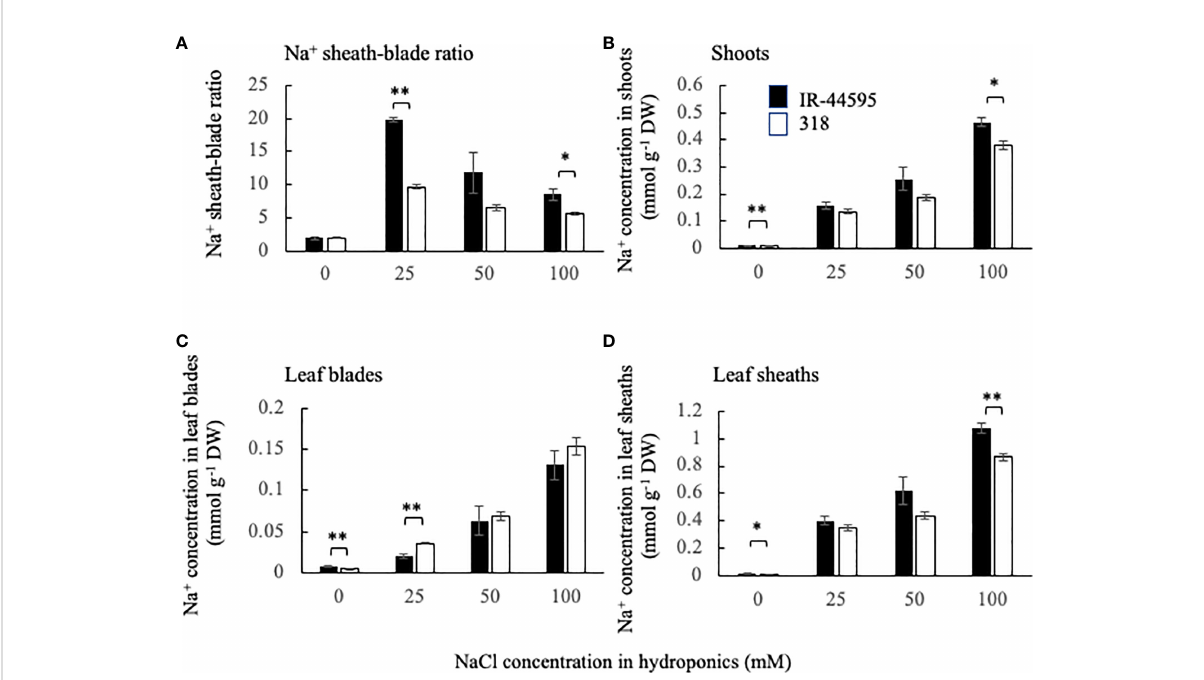
FIGURE 1 Varietal difference of Na + sheath-blade ratio (A) and Na + accumulation in shoots (B) , leaf blades (C) , and leaf sheaths (D) . Black and white bars represent IR-44595 and 318. Data are mean of four replications ± the standard error. * and ** indicate signi fi cant difference at P<0.05 and 0.1 between IR-44595 and 318 under each treatment (Student ’ s t